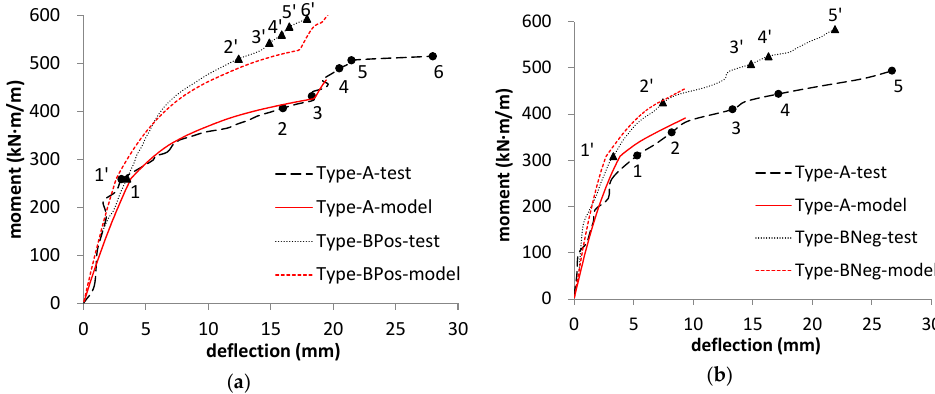
Figure 13. Evolution of the joint deflection with increasing bending moments: ( a ) positive cases; ( b ) negative cases.